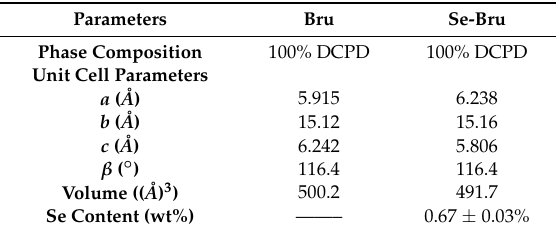
Table 1. Various parameters of the obtained materials.